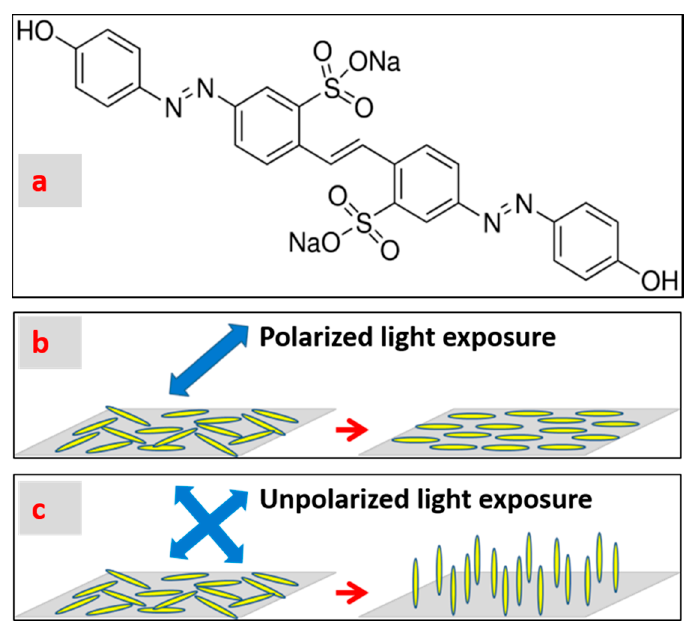
Figure 1. ( a ) Molecular structure of brilliant yellow. ( b ) When exposed to polarized light, brilliant yellow molecules undergo in-plane re-orientation to a direction of 90 degrees with respect to the light polarization direction. ( c ) When exposed to un-polarized light, brilliant yellow molecules undergo out-of-plane re-orientation to a direction along to the light propagation direction.